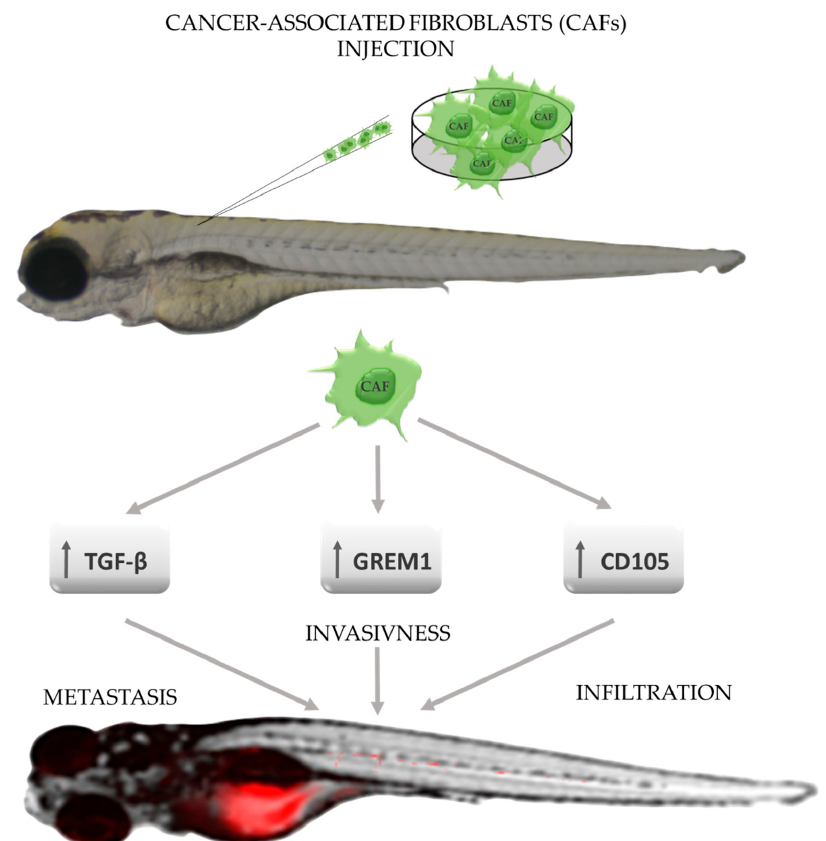
Figure 4. The role of cancer-associated fibroblasts (CAFs) in promoting tumor progression in zebrafish xenografts. CAFs—cancer-associated fibroblasts; CD105—endoglin, homodimeric transmembrane glycoprotein belongs to TGF- β family receptors, GREM1—gremlin 1, bone morphogenic protein antagonist; TGF- β —transforming growth factor β (based on results shown by Sun DY et al., Ren J et al., and Paauwe M et al.) [84–86].